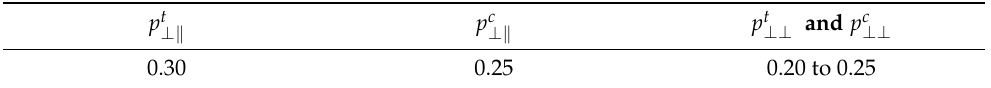
Table 1. Recommended inclination parameters for GFRP, adapted from [50], Composites Science and Technology,